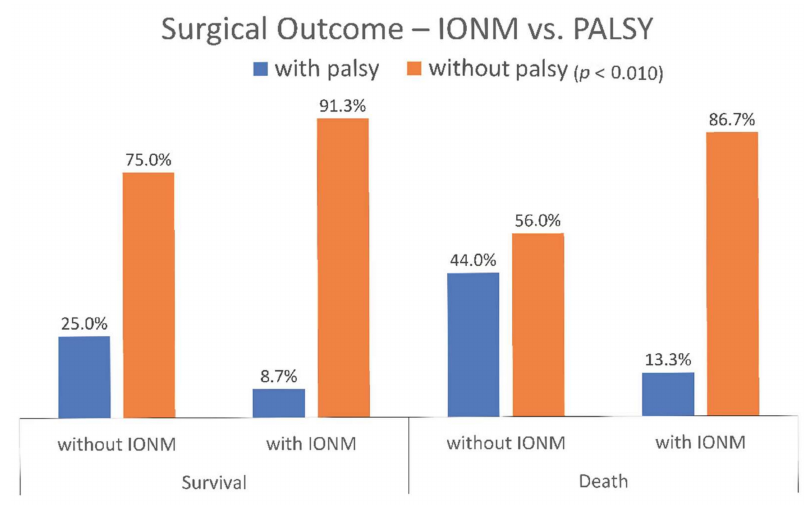
Figure 1. Percentage of IONM use and palsy observed by survival status.